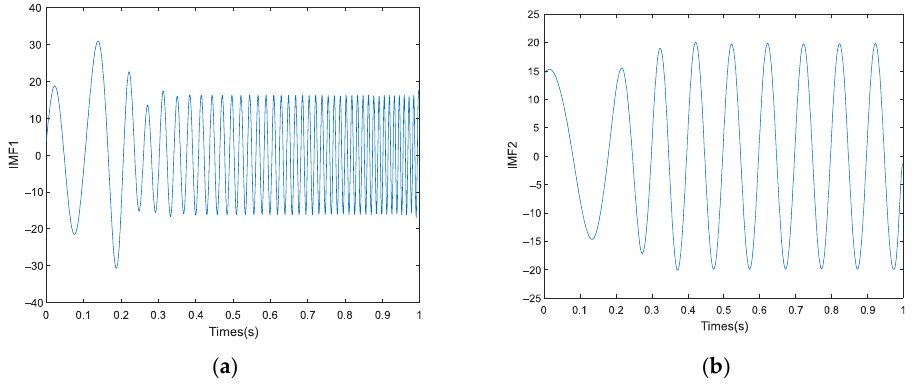
Figure 7. Performance of prediction under the EMD: ( a ) IMF1; ( b ) IMF2.